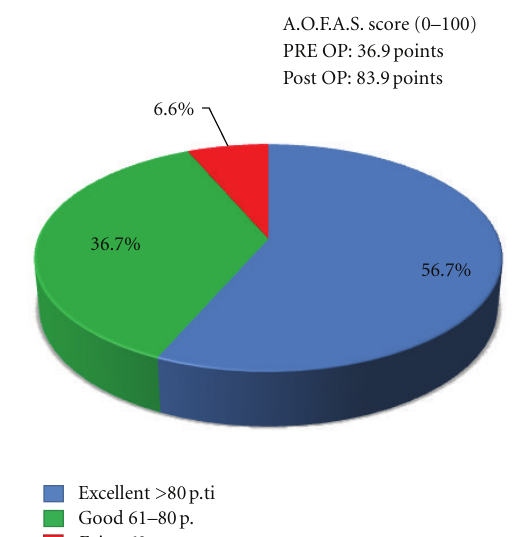
Figure 5: AOFAS score at final follow-up.